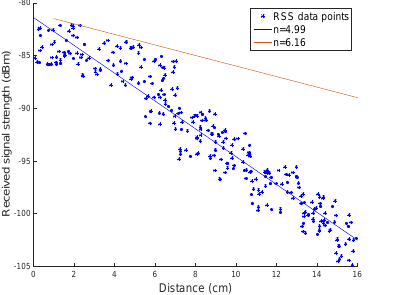
Figure 6: RSSI as a function of dis-